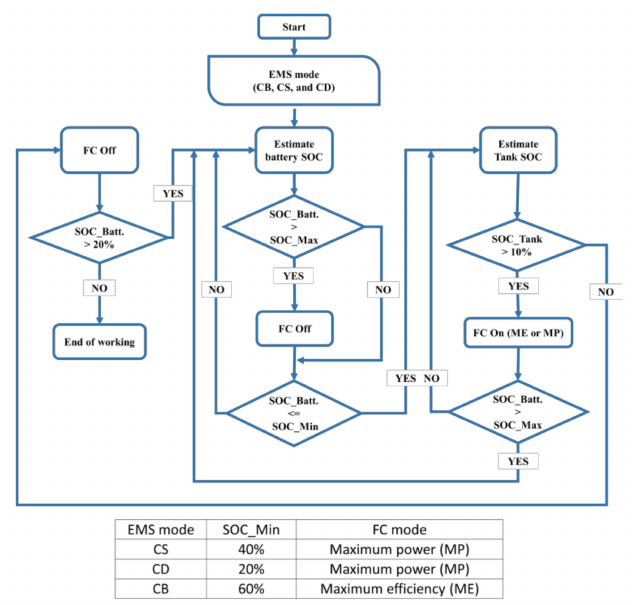
Figure 3. Flow chart of the proposed energy management strategy (EMS).